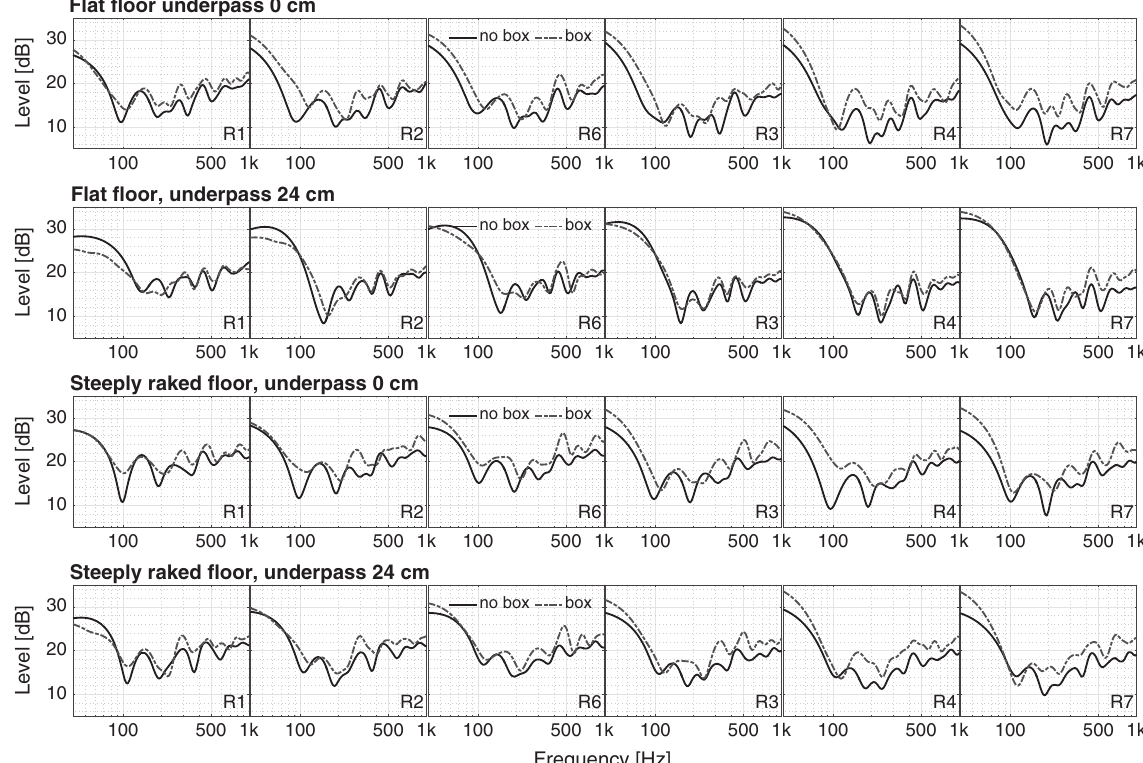
Figure 6. The effect of adding the concert hall geometry at 15 ms after the direct sound. The responses are 1/3 octave